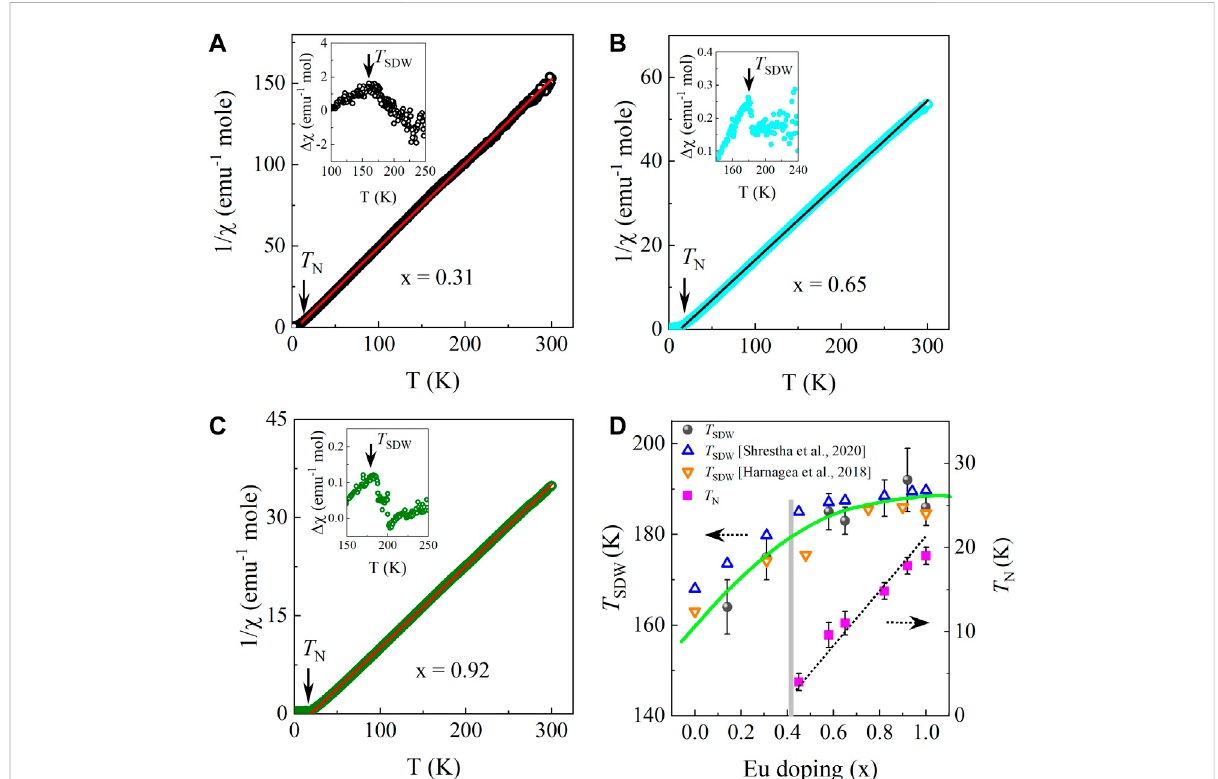
FIGURE 3 Curie-Weiss fi t. Inverse susceptibility, 1/ χ , vs. T for ECFA samples at (A) x = 0.31, (B) x = 0.65, and (C) x = 0.92.1/ χ increases linearly with T , consistent with Curie-Weiss behavior.The arrows show theAFM due to theEu 2+ spins. The solidlines are thebest- fi tlines usingthe Curie-Weiss law Eq.1.Theinsetsin (A) – (C) displaytherespective Δ χ vs. T plotsshowingthe T SDW transitions,asindicatedbythearrowineach. (D) T SDW (solidspheres) and T N (solid squares)vs. x for ECFAsamples. Open upright andinverted trianglesare T SDW datafromRefs (Shrestha etal.,2020).and(Harnagea etal.,2018),respectively. T SDW increases rapidlywith increasing x andthen slowlysaturates to T SDW ~190 Kabove x ~0.4.Theerrorbarsaretaken as the half-width of the transition. The vertical solid stripe and solid curve are guides to the eye. T N fi rst appears at x ~ 0.4 and increases almost linearly with further increasing x , as indicated by the dotted